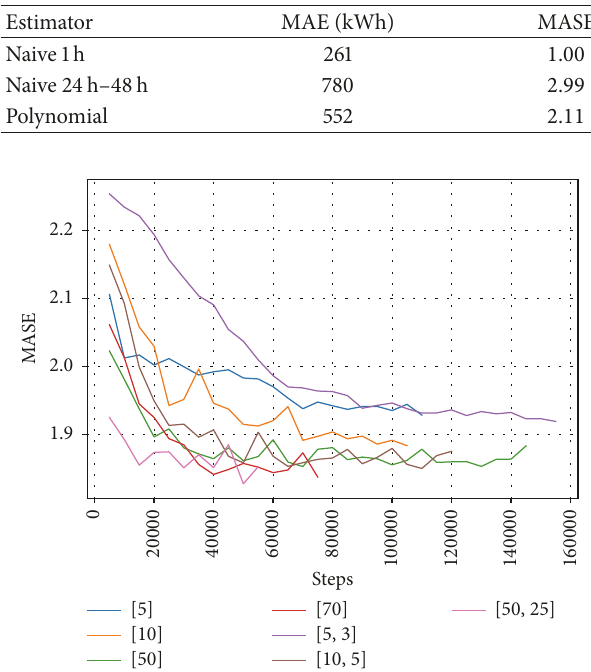
Table 3: Accuracy of current estimators.